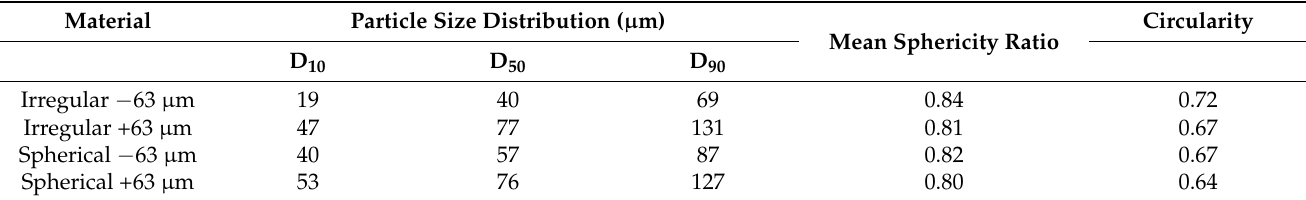
Table 5. The summary of the powder distribution and shape of the spheroidised powder.